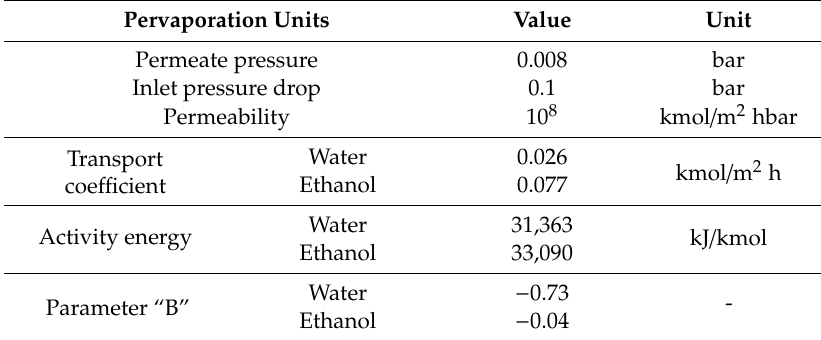
Table 3. Organophilic pervaporation membrane parameters for ethanol-water mixture (PERVAP ™ 4060 type membrane)